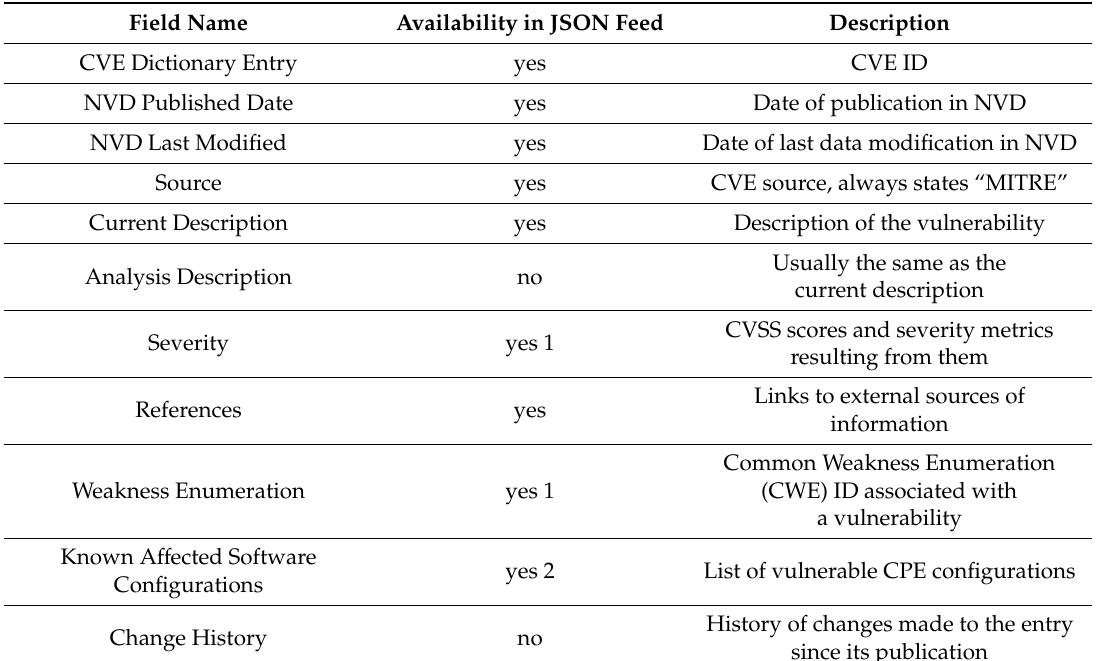
Table 2. Data fields presented in the NVD